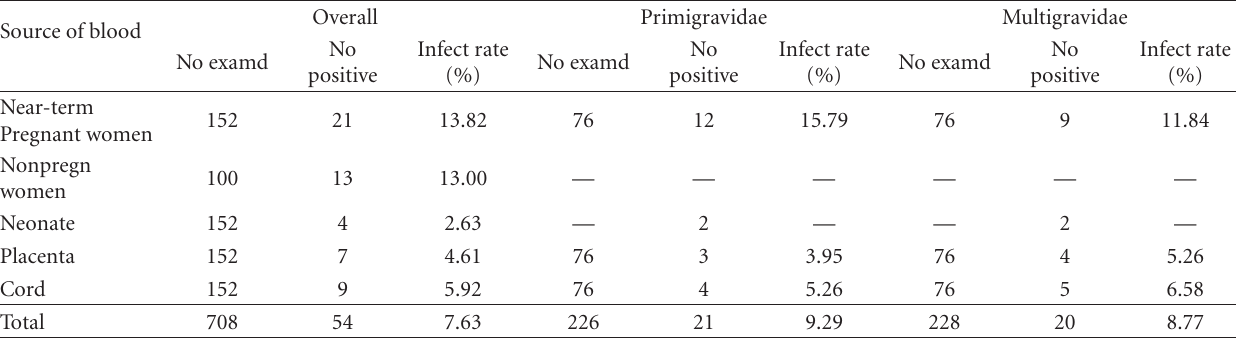
Table 1: Prevalence of Plasmodium falciparum in blood samples of di ff erent groups of women and tissues at General Hospital Minna, North Central